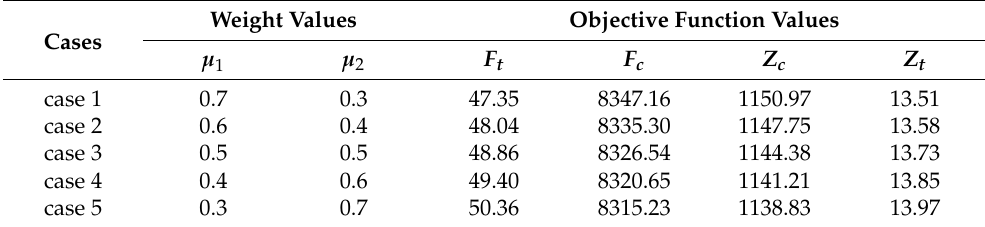
Table 9. Weight sensitivity analysis.